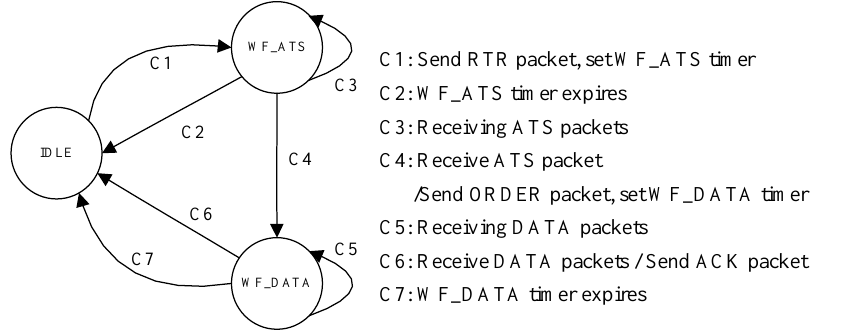
Figure 3. The state transition diagram of the sink. RTR—ready to receive; ATS—available to send; WF_ATS—wait for ATS.